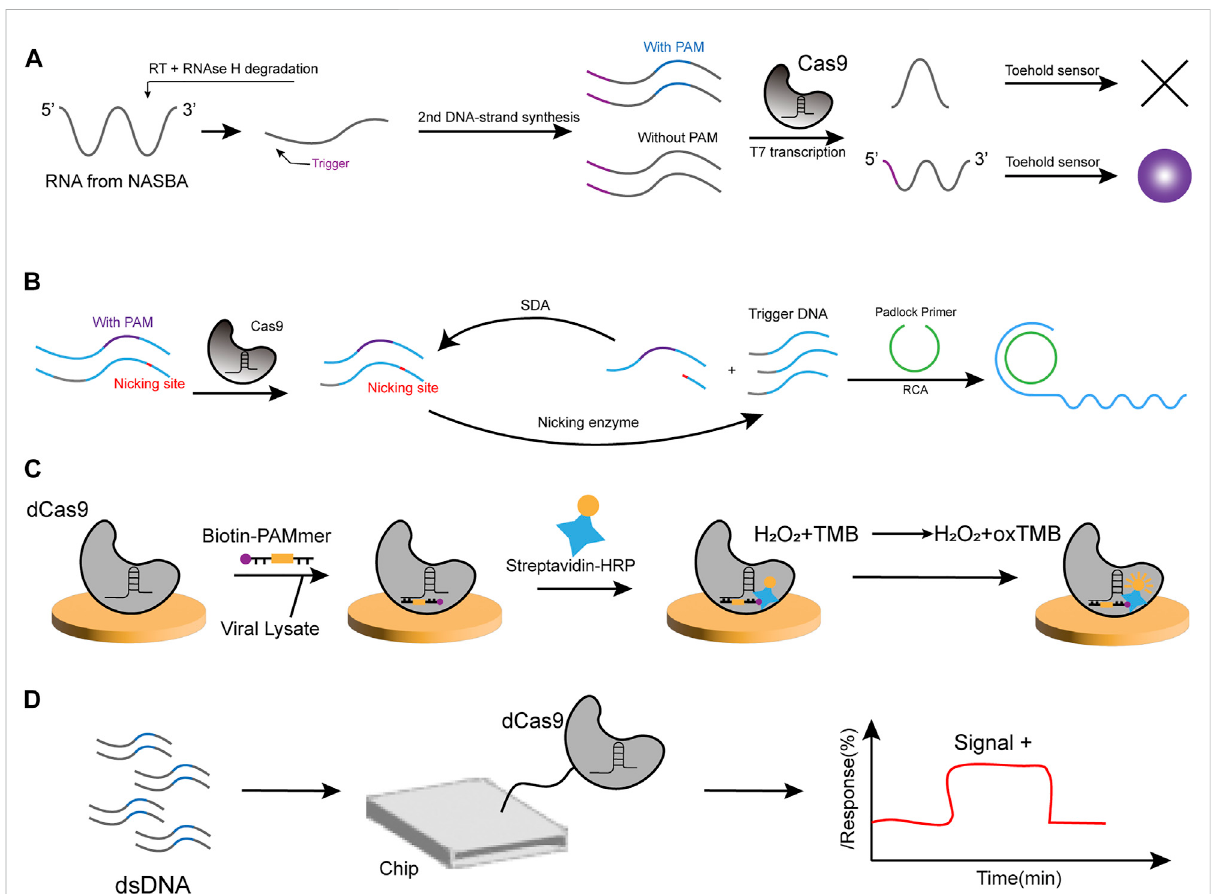
FIGURE 2 Strategies for Cas9-based nucleic acid sensor. (A) NASBA ampli fi es the RNA target, and the trigger sequence for the toehold switch is introduced.Subsequently, theRNAandDNAhybridization producesRNAthat isdegraded byRNAse H.The second DNA strand issynthesized,and it carries the T7 promoter sequence. The transcribed RNA can be used as starting material for NASBA and interact with the toehold switch. In the presence of PAM sequences, the RNA target site is shorter due to the cleaved template and cannot activate the sensor, and vice versa, producing a signi fi cant color change. (B) In the action of Cas9, broken dsDNA at the nicking site is further recognized by the nicking enzyme. Once theDNA polymerasereaches the nicking site, anew strand canbe generated and the downstream strandis replaced. As aresult, many short ssDNAs are generated to trigger rolling circle ampli fi cation (RCA). Subsequently, the RCA product can bind to oligonucleotide-spliced AuNPs, inducing the aggregation of AuNPs. SDA, Strand-displacement ampli fi cation. (C) Viral lysate and biotin-PAMmer are added to microplates immobilized with dCas9/gRNA complexes. Following, Streptavidin-HPR and TMB substrate solutions were added to the microplate. Finally, the yellow color is observed in the presence of the virus. (D) The CRISPR-chip is composed of a gFET structure with a complex of sgRNA and dCas9 formed on